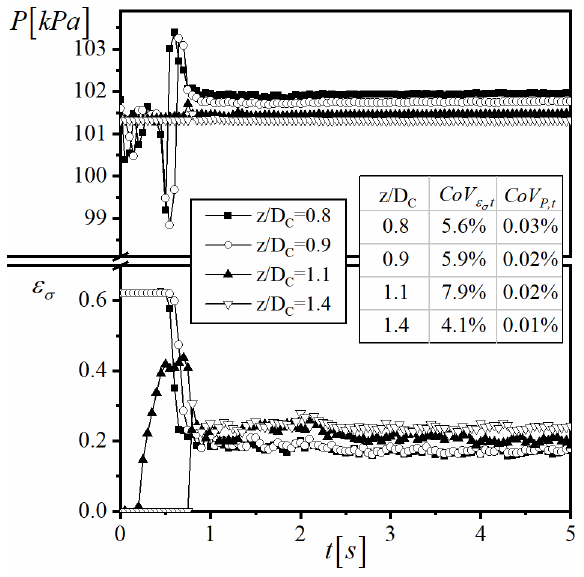
Figure 5. Timewise change of the absolute pressure and solids holdup at different axial locations and r = 0 in a spouted bed packed with 2 mm glass beads, H σ ,0 = 160 mm and